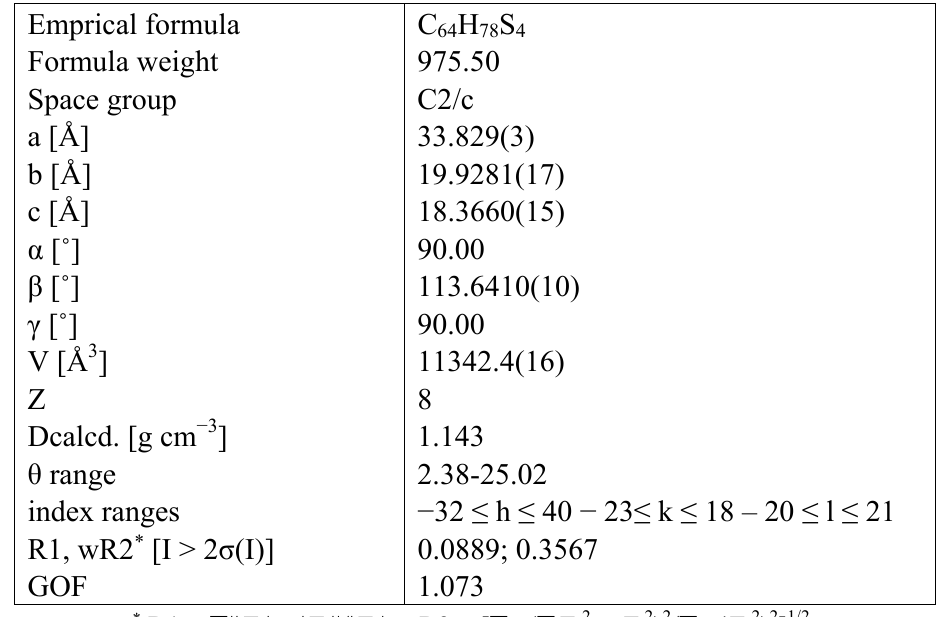
Table 2. Crystal data and structure refinement information for THTP-C.